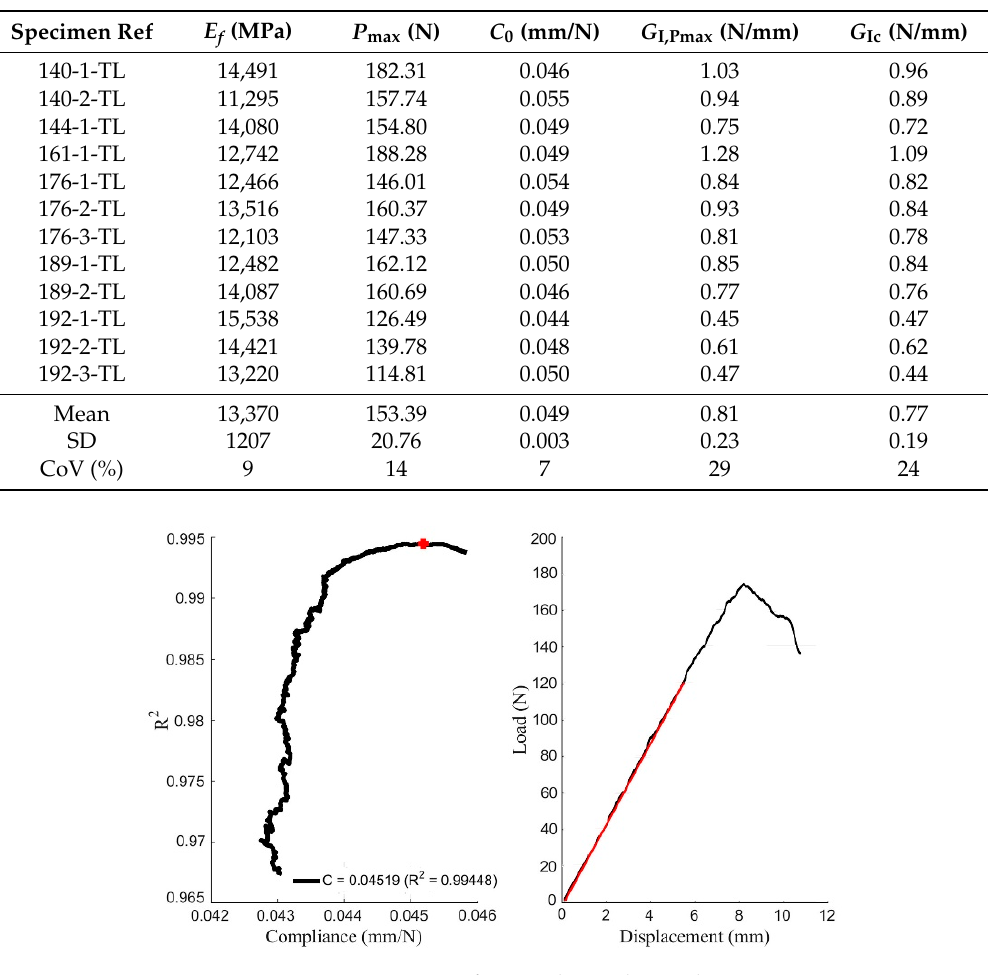
Figure 5. Representative curves for initial compliance determination.